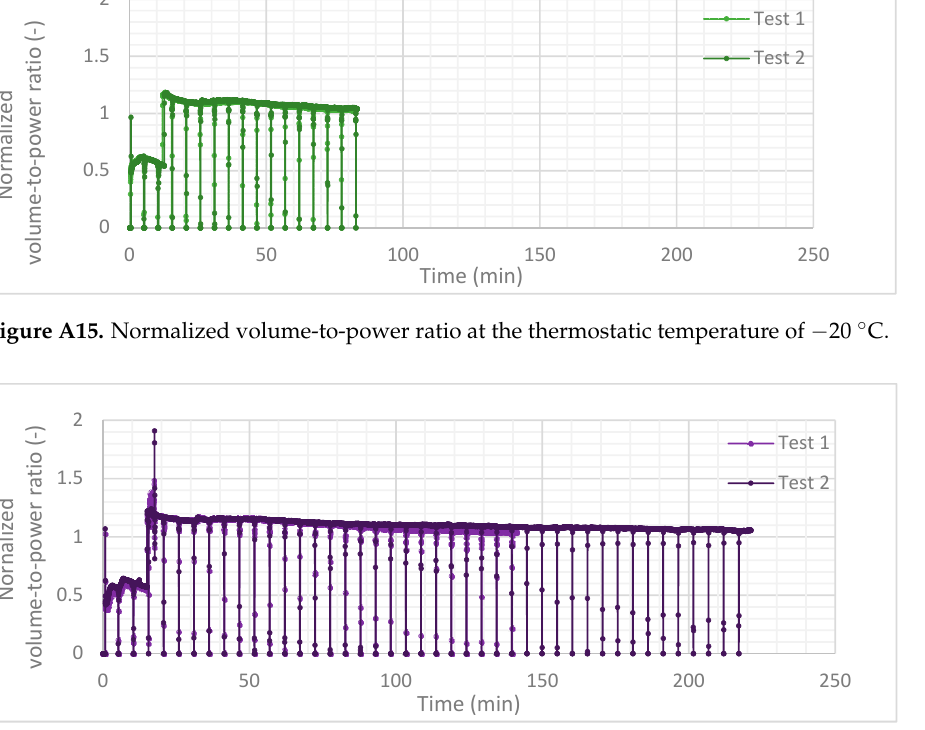
Figure A16. Normalized volume-to-power ratio at the thermostatic temperature of − 30 °C.